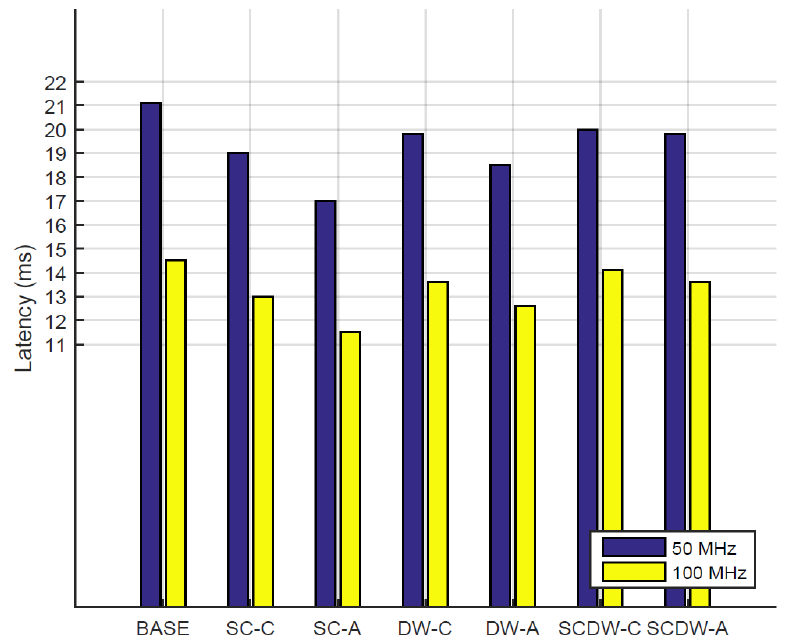
Figure 7. The inference latency of each pruning configuration, measured in milliseconds.